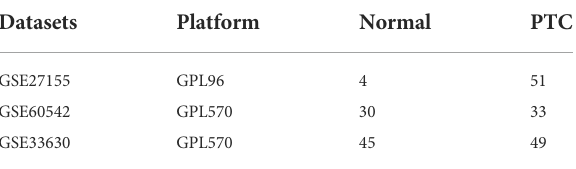
TABLE 1 Source of